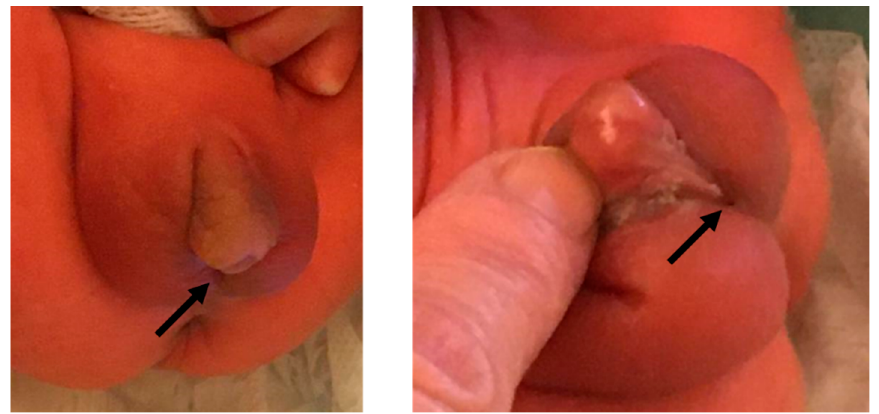
Figure 1. External genitalia of II-3 newborn at birth. Perineal hypospadias (black arrow) with small penis, hyper pigmented and fused scrotal folds containing palpable oval formations.